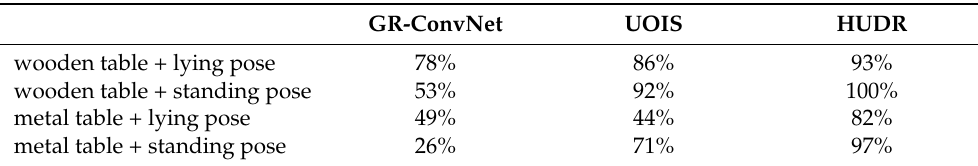
Table 1. Success rate